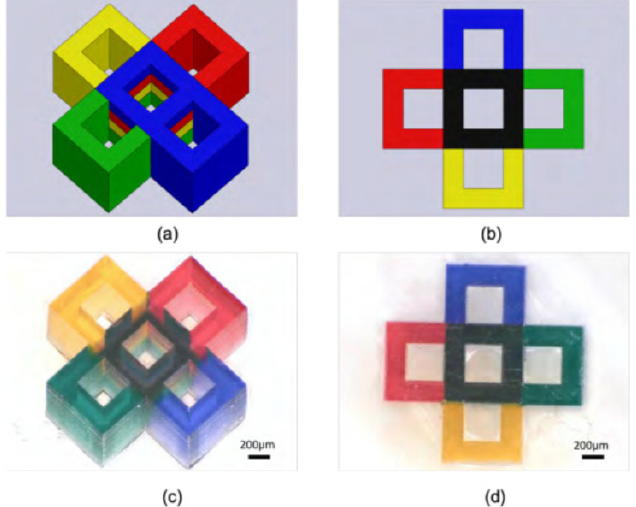
Figure 16. Micro-SLA-fabricated 3D cross-shape, printed with multicolour resins. The modelled CAD geometry is shown from orthogonal ( a ) and top-view ( b ) angles alongside the finished part at orthogonal ( c ) and top view ( d ) angles. Here, scale bars are 200 μ m [111].